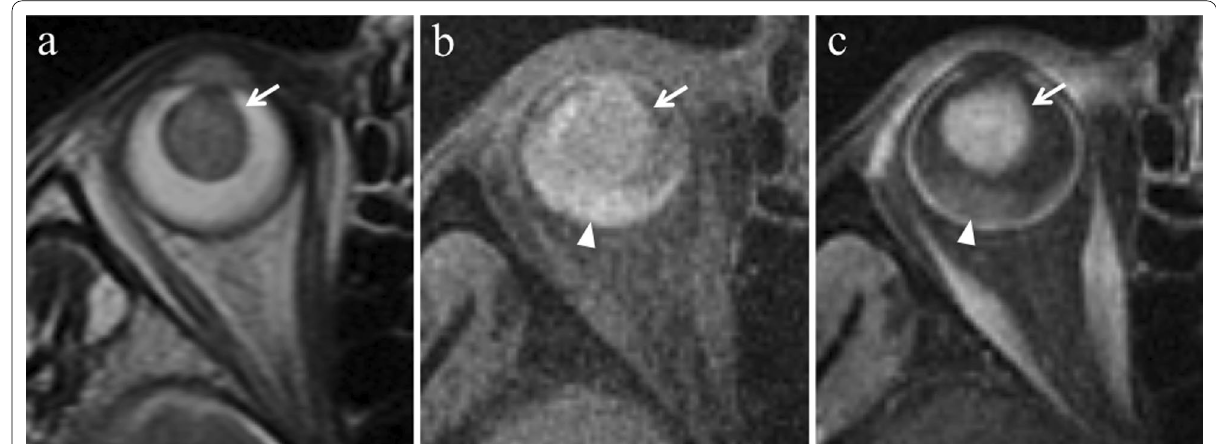
Fig. 15 A 79-year-old woman with a poorly pigmented choroidal melanoma and hemorrhagic retinal detachment of the right eye. The same patient as in Fig. 8. Axial ( a ) T2-weighted turbo spin-echo STIR and ( b ) fat-suppressed T1-weighted images reveal an intraocular mass with intermediate signal intensity (white arrows), consistent with a poorly pigmented melanoma. Along the posterior aspect of the globe, the hemorrhagic retinal detachment is better depicted on fat-suppressed T1-weighted image in which it displays high signal intensity due to subacute blood products (white arrowhead). On ( c ) contrast-enhanced fat-suppressed T1-weighted image the lesion enhances (white arrow), whereas the retinal detachment does not enhance (white